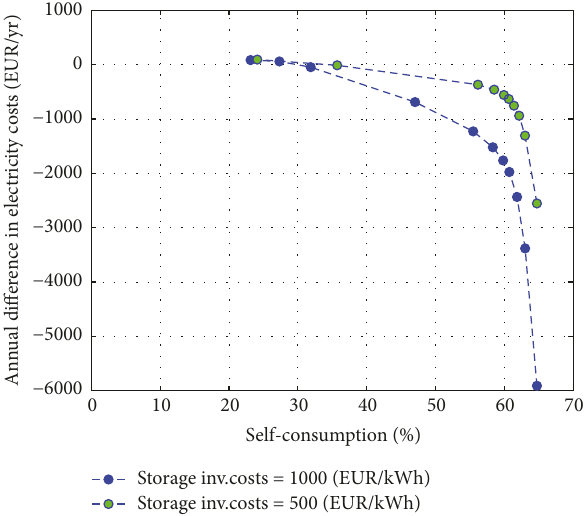
Figure 20: Austrian retail electricity prices: annual electricity cost